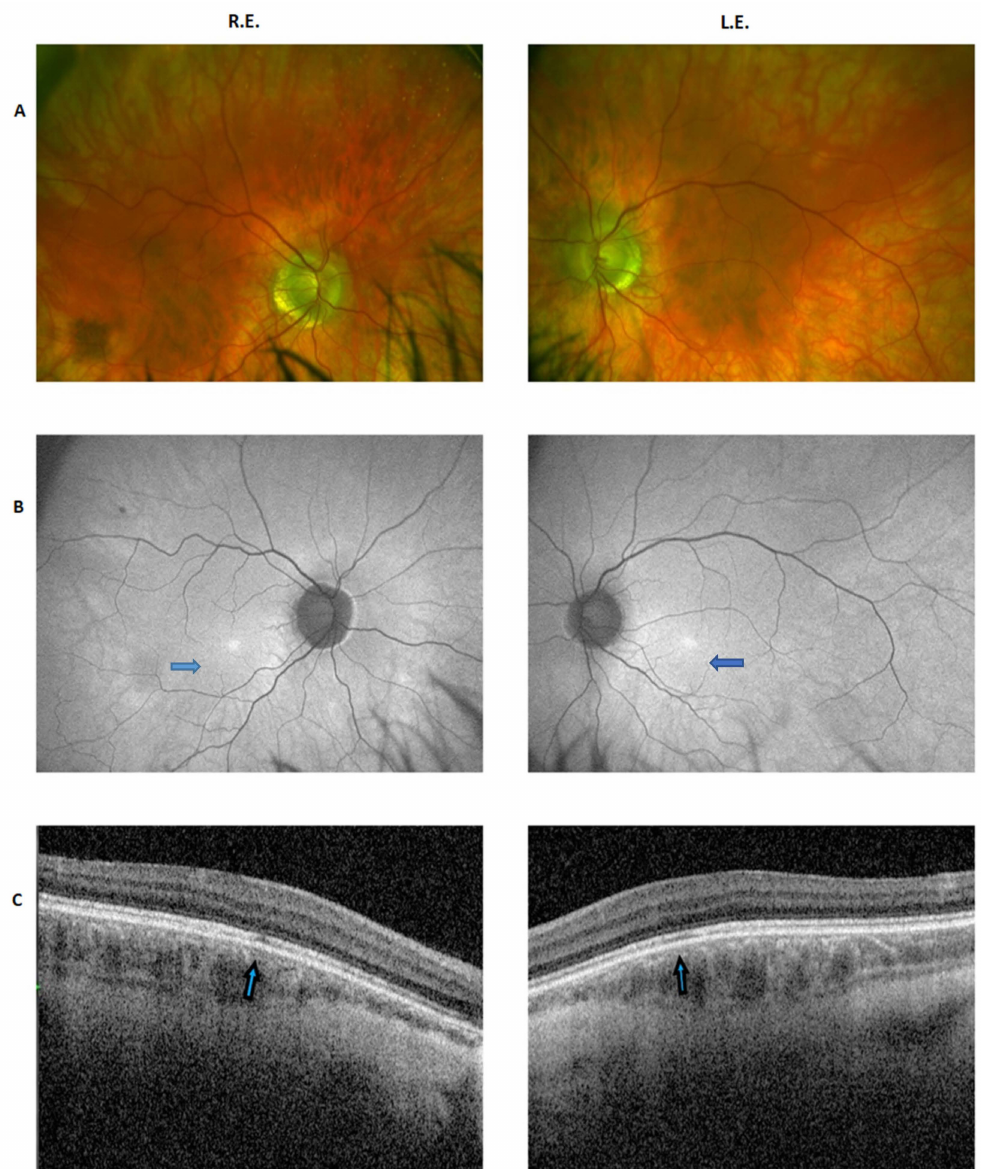
Figure 1. Ophthalmic features of the proband. ( A ) Fundus images (Daytona wide-field retinography) of the right and left eye showing a myopic pattern with relatively pale optic disk, regular vessel caliber, and mild RPE mottling. ( B ) FAF images (Daytona wide-field retinography) showing a slightly abnormal distribution of the superficial retinal vessels and a hyperfluorescent irregular elliptic area of approximatively 400 µ m diameter corresponding to the hypoplasic fovea (arrows). ( C ) SD-OCT macular scan showing the absence of foveal depression, a thickening of the deep choroideal vessels (Haller’s layer), and a thinning and slight fragmentation of the ellipsoid layer in the central fovea (arrows) corresponding to an areola of approximately 300 µ diameter, associated with fragmentation of the corresponding external limiting membrane (EML). A slight widening of the outer nuclear layer (ONL) and inner nuclear layer (INL) in the same area is associated with irregular optical density of the